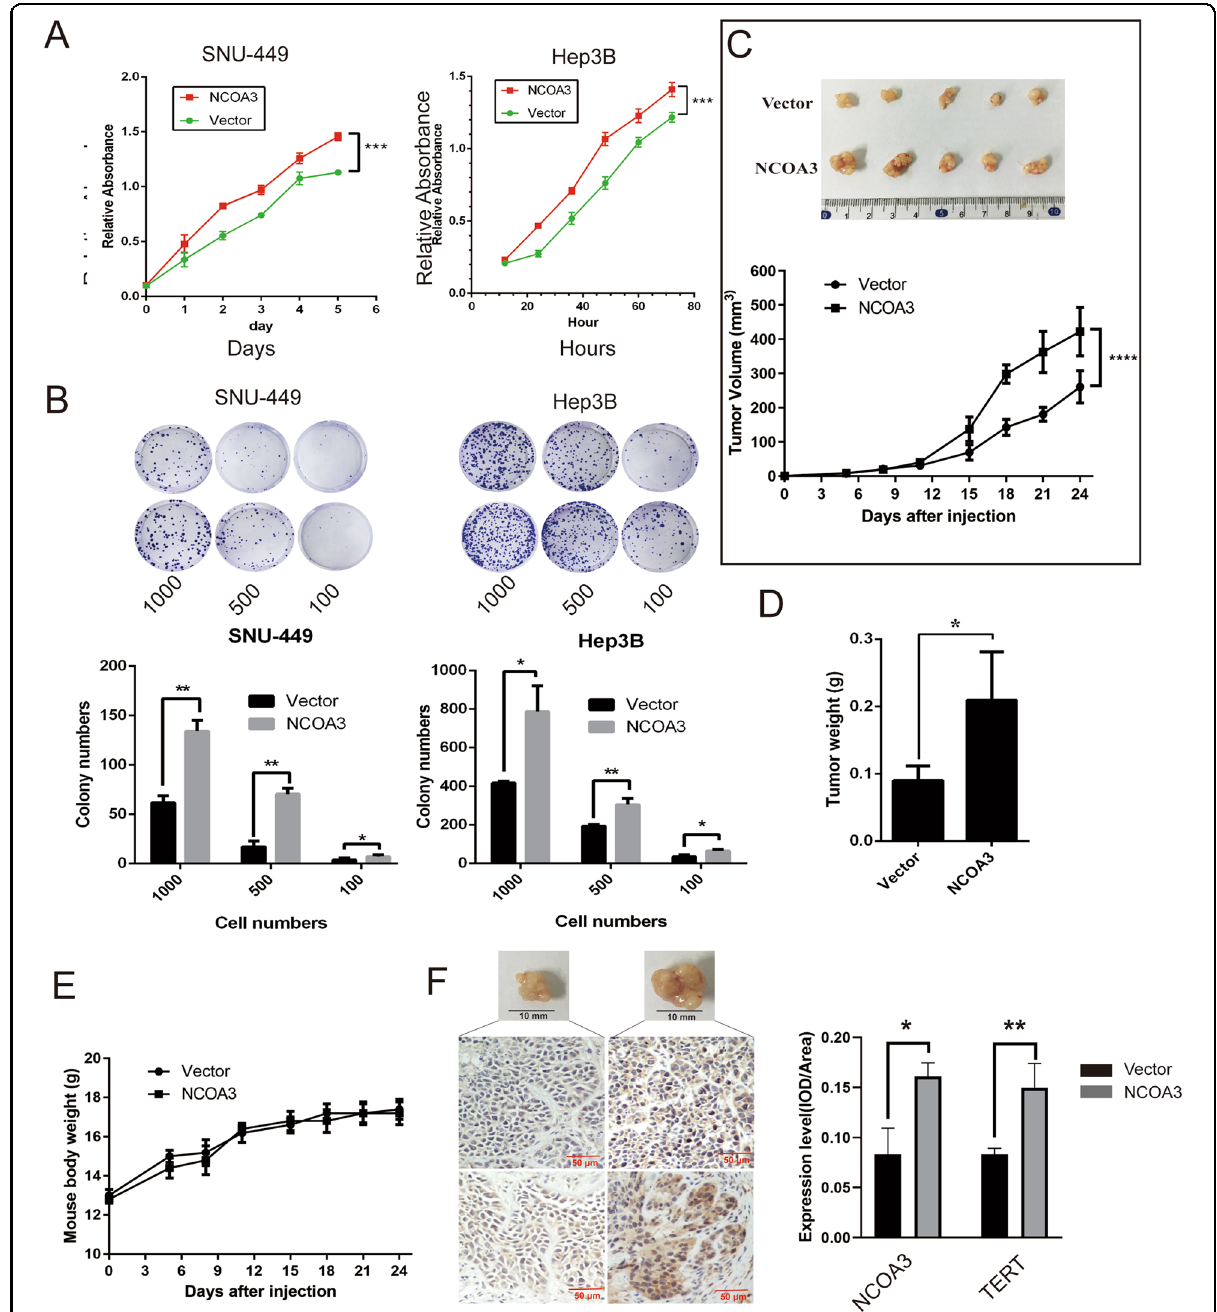
Fig. 3 Overexpression of NCOA3 promoted HCC cell growth in vitro and in vivo. A Viability of SNU-449 and Hep3B cells with NCOA3 overexpression was determined by MTS assay. B The colony formation ability of SNU-449 and Hep3B cells with NCOA3 overexpression. The colonies were stained by crystal violet and counted. C Nude mice were subcutaneously injected with Hep3B cells with vector or NCOA3 overexpression. Images of the HCC tumor xenograft from each mouse ( n = 5 mice/group) were captured, tumor volumes were recorded every 3 days, D tumor weights were analyzed, E mouse body weights were monitored, and F the expression of NCOA3 and TERT in tumor tissues were detected by IHC staining. The data were shown as means ± SD, * P < 0.05, ** P < 0.01. *** P < 0.001, Student ’ s t